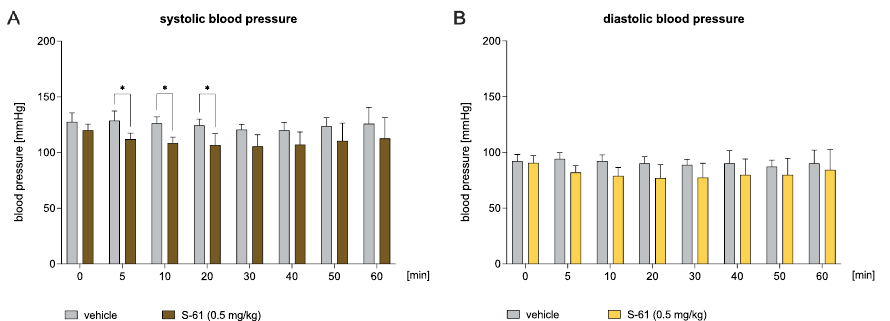
Figure 2. The effect of S-61 on the systolic (Panel A ) and diastolic blood pressure (Panel B ) in the normotensive rats. The blood pressure was measured before and 5, 10, 20, 30, 40, 50, and 60 min after the intravenous ( iv ) administration of either S-61 at a dose of 0.5 mg/kg or vehicle (saline). The results are presented as means ± SD. Statistical analysis: two-way repeated measures ANOVA (Bonferroni post hoc); * p < 0.05; n = 6 rats. = 4.315, p < 0.001; Treatment: F(1,10) = 43.52, p < 0.0001; Time × Treatment: F(7,70) = 2.076, ns; Figure 3A) and diastolic blood pressure (Time: F(7,70) = 2.062, ns; Treatment: F(1,10) = 11.50, p < 0.01; Time × Treatment: F(7,70) = 0.6238, ns; Figure 3B). We observed a decrease